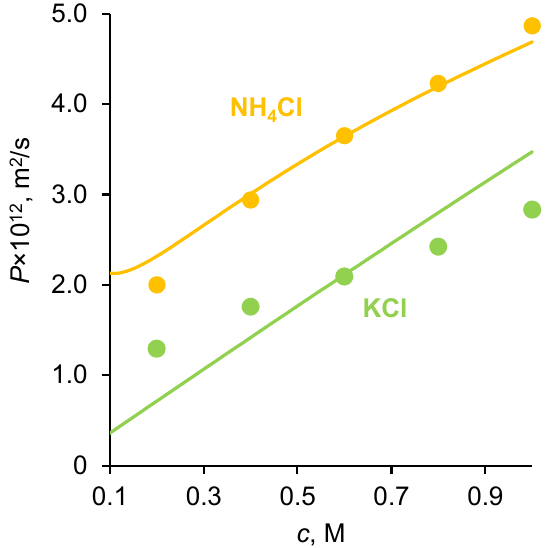
Figure 5. Dependence of the experimental (dots) and theoretical (lines) integral diffusion permeability coefficients of NH 4 Cl and KCl on the concentration of the external solution in the membrane system with the AMX membrane. The model parameters used in the calculation are presented in Table 1. Table 1. Input parameters of the model for the system under